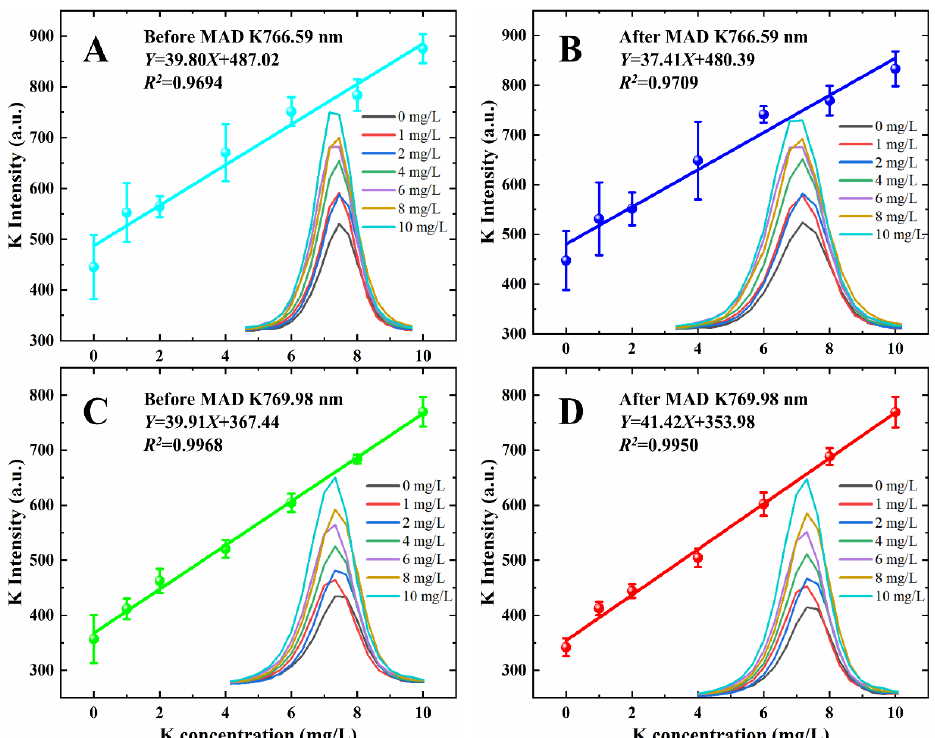
Figure 8. ( A ) Calibration curve of K 766.59 nm before MAD; ( B ) calibration curve of K 766.59 nm after MAD; ( C ) calibration curve of K 769.98 nm before MAD; ( D ) calibration curve of K 769.98 nm after MAD. The error bars are the standard deviations of three replications. The bottom right picture is spectral intensity of samples with different K contents in solution.